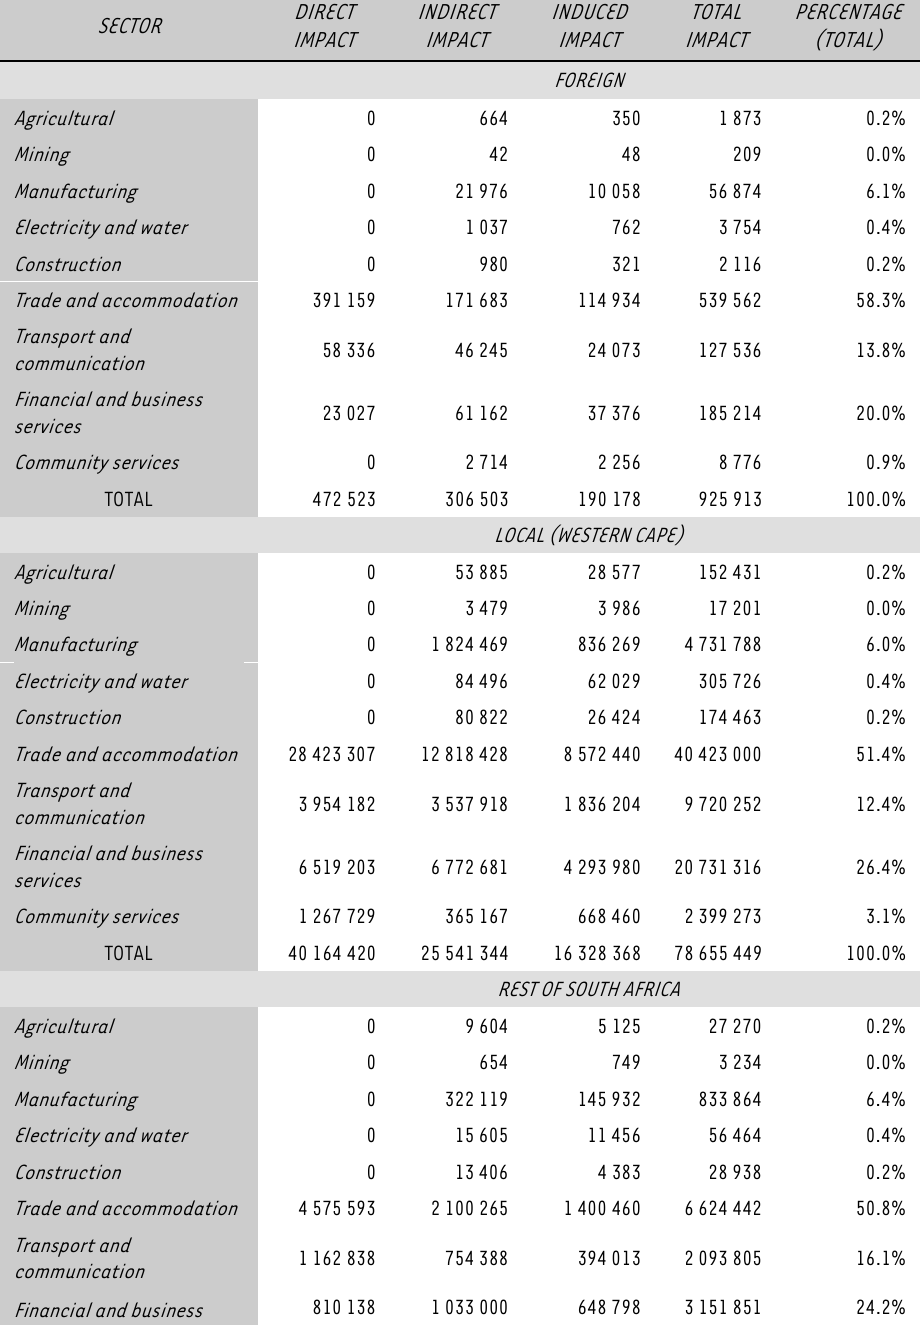
TABLE 2: Impact through production multipliers (ZAR, 2006 prices) – foreign, local (Western Cape), rest of South Africa and total DIRECT INDIRECT SECTOR IMPACT